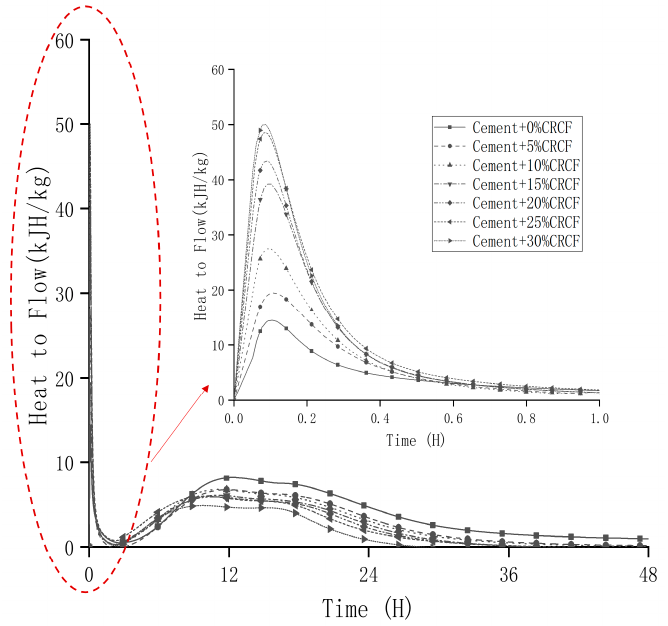
Figure 10. Heat evolution of cement with different CRCF contents.